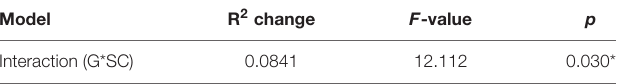
TABLE 7 | Test of higher-order unconditional